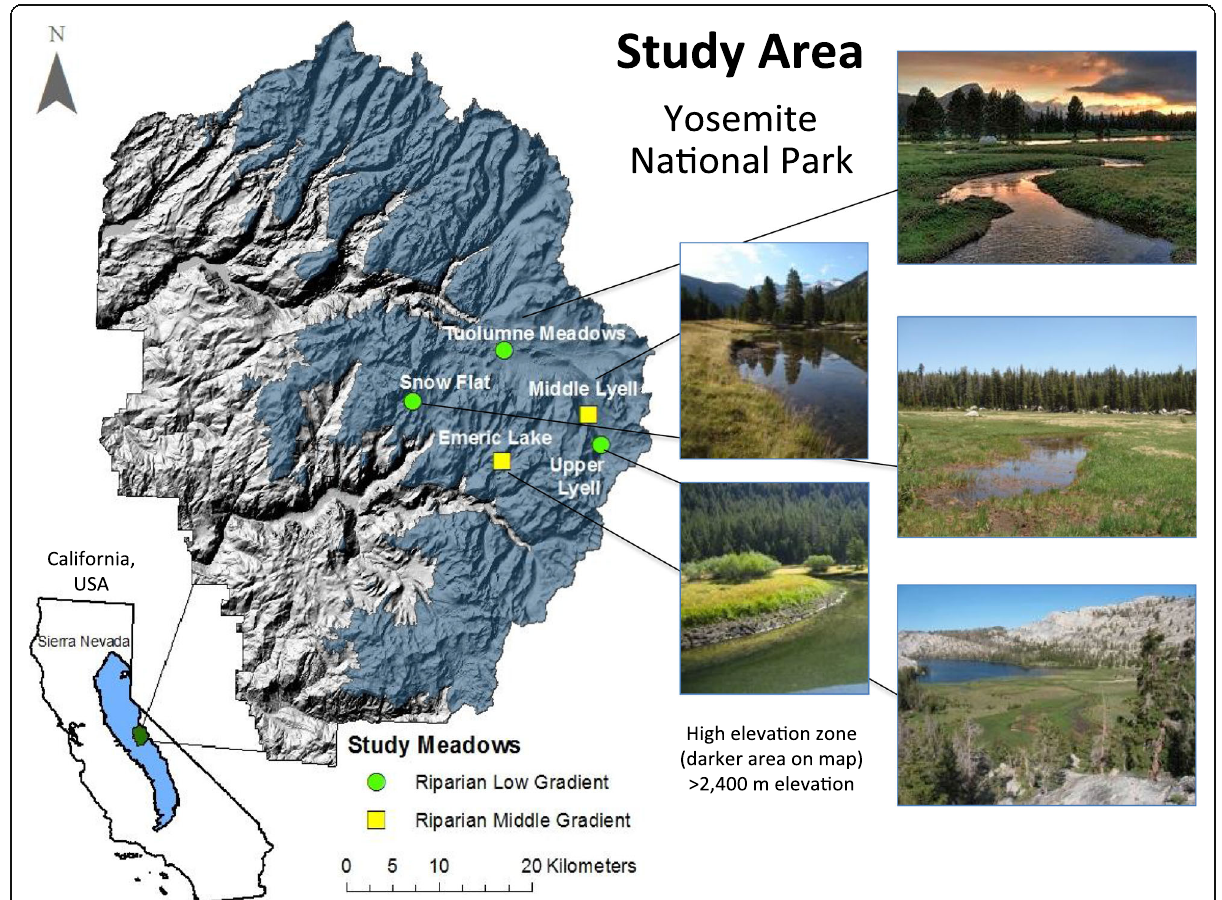
Fig. 1 Study area map depicting high-elevation meadows (> 2400 m) sampled in Yosemite National Park, central Sierra Nevada of California, USA. Points on map depict study meadows used to evaluate explanatory factors of soil resistance by hydrogeomorphic type and appearance (green circles: low gradient meadows, < 2% slope, yellow squares: middle gradient meadows, 2 – 4%